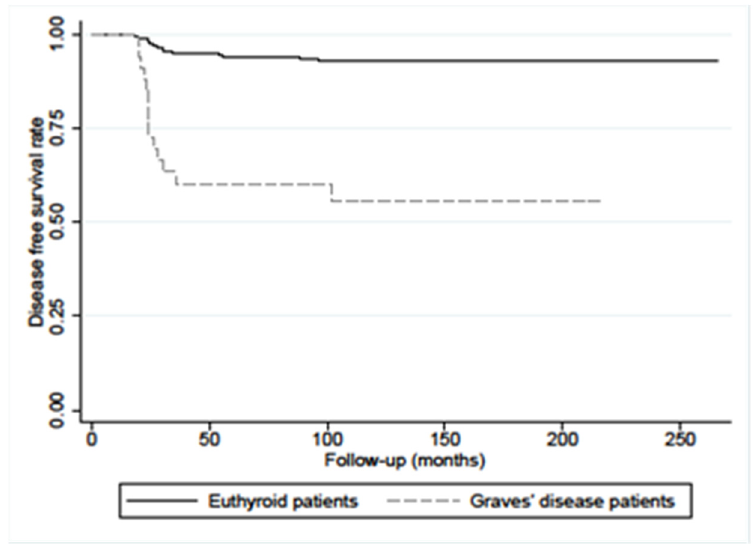
Figure 3. Disease-free survival (DFS) in PC/GD patients (n.33) and in matched euthyroid PC control patients (n.312) showed a statistical difference ( p < 0.0001 calculated with log-rank test).